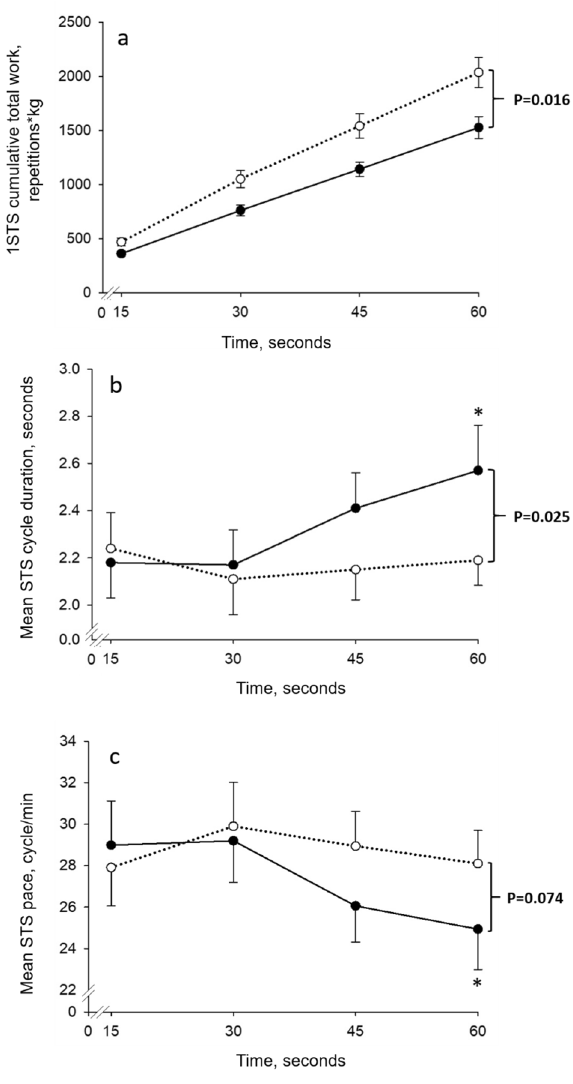
Figure 1. Time course of cumulative total work during the 1-min sit-to-stand (1STS) ( a ), mean duration time of two sit-to-stand cycles at 15 s, 30 s, 45 s, and 60 s of the 1STS ( b ), and mean pace during the 1STS at 15 s, 30 s, 45 s, and 60 s of the 1STS ( c ) in people with COPD (full circles) and healthy controls (open circles). Results are presented as mean ± SD. Data were not recorded for three people with COPD and four healthy controls because of technical problems with the electrogoniometer. Overall, the pattern of changes in cumulative total work differred between groups during 1STS ( p = 0.016) ( a ) as a result of a progressive deceleration during 1STS that was observed only in people with COPD ( p < 0.01). * p < 0.01, 60 s compared to 15 s. The p values report the interaction group × time during the